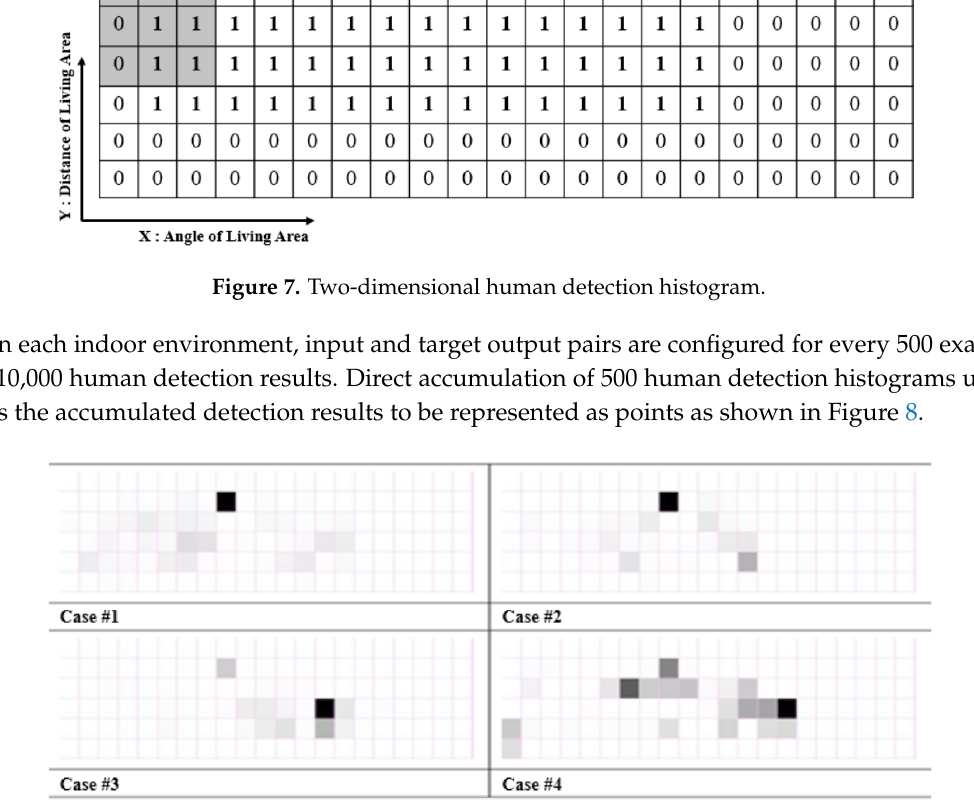
Figure 8. Accumulated 500